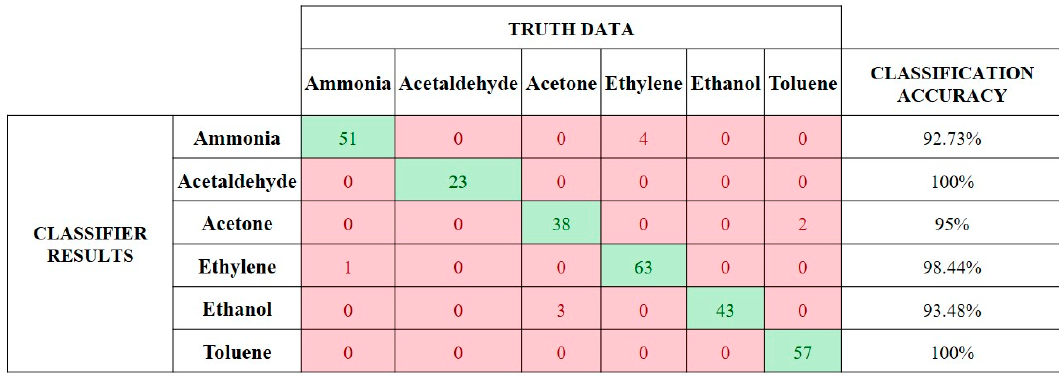
Figure 7. Confusion matrix showing classifier accuracy for [20] dataset.